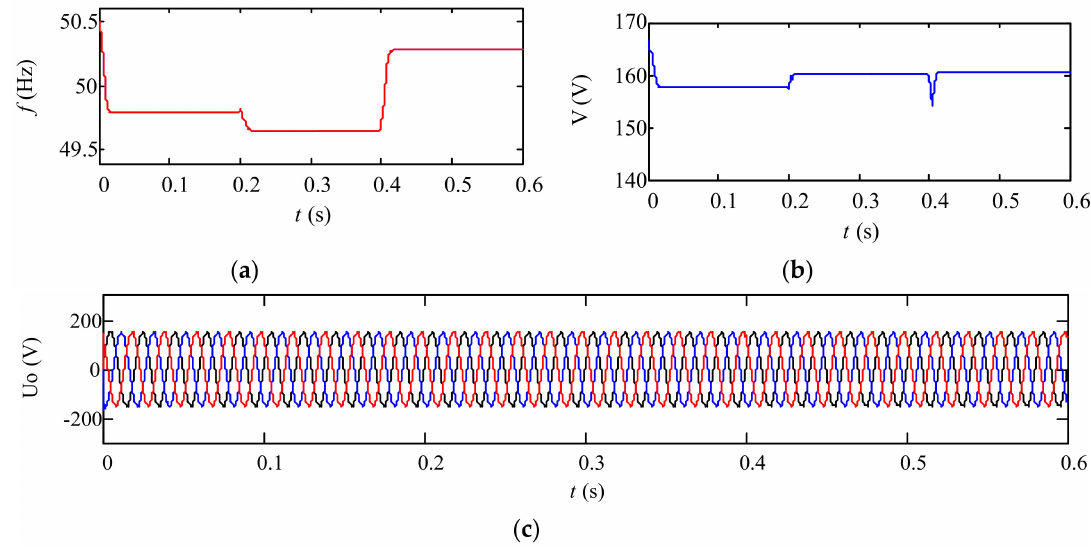
Figure 12. Voltage waveforms with the proposed control method. ( a ) frequencies of the three-phase reference voltage; ( b ) amplitudes of the three-phase reference voltage; ( c ) instantaneous output voltage.